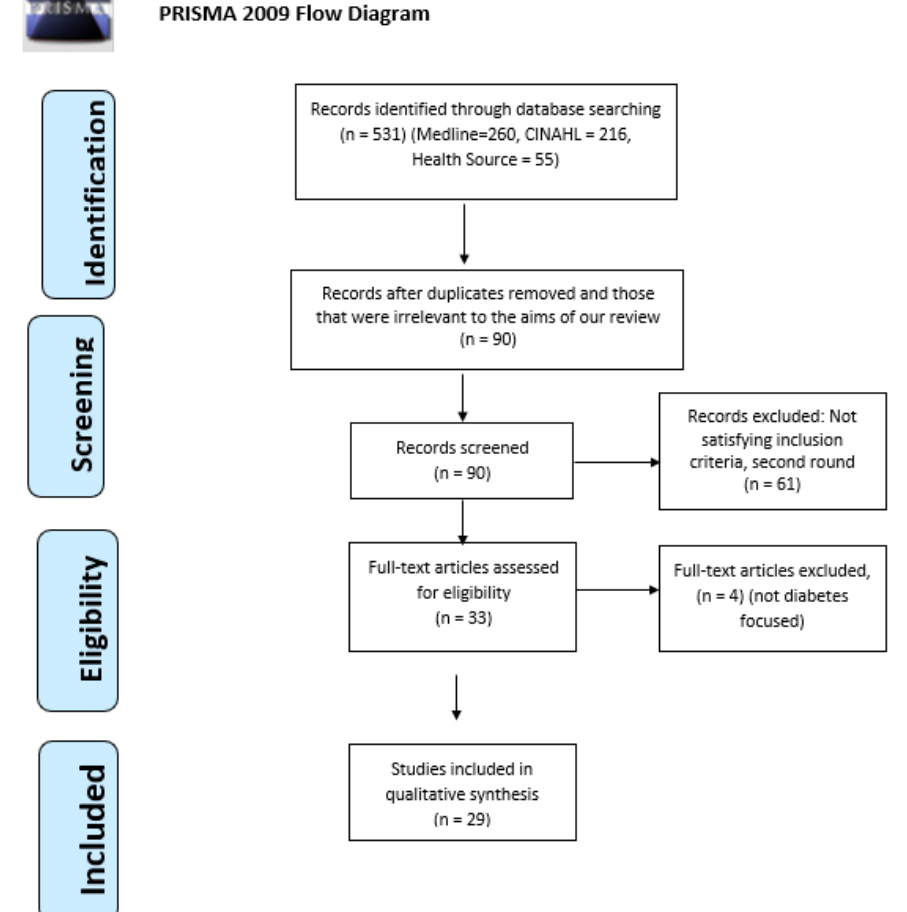
Figure 1. PRISMA flowchart with the search strategy of the systematic review.